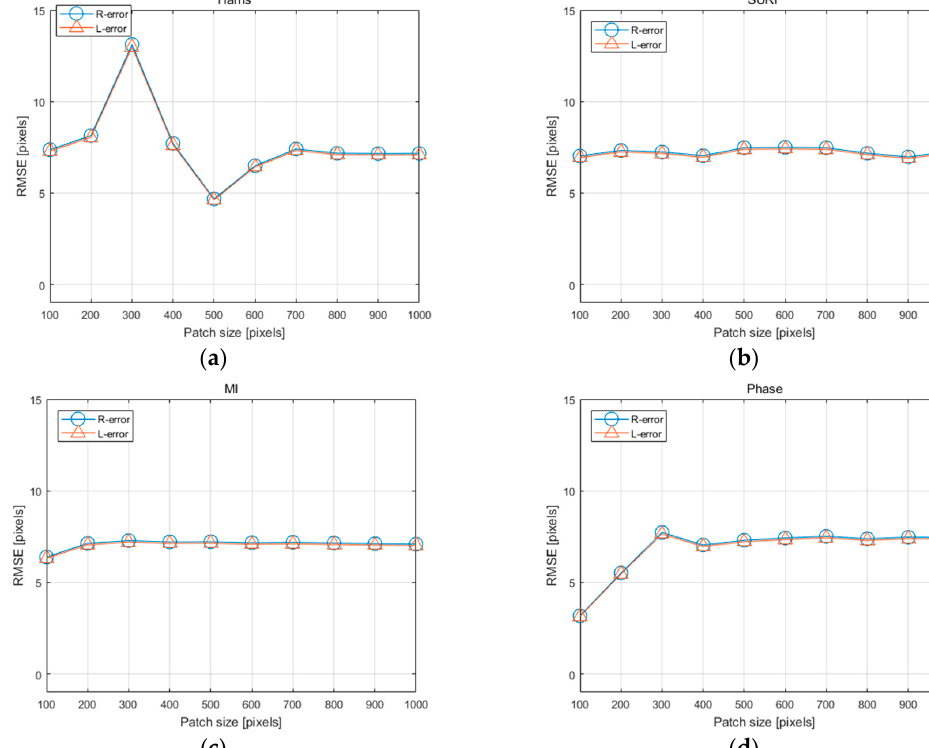
Figure 15. Reprojection errors (along-track Kompsat-3 coarse epipolar—before adjustment): ( a ) HARRIS–FREAK ( b ) SURF, ( c ) MI, and ( d ) PC.